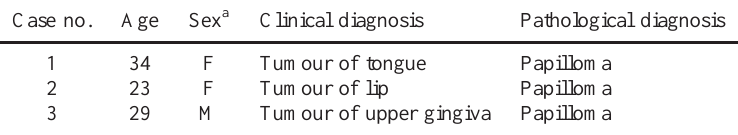
Clinicopathological characteristics of the biopsy specimens Case